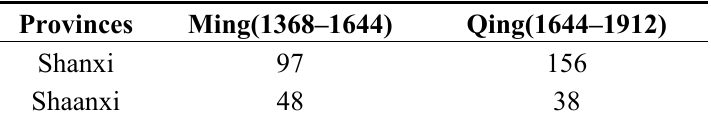
Table 1. The number of water projects in Shanxi and Shaanxi in the Ming and Qing dynasties. Source : Chi (1936)